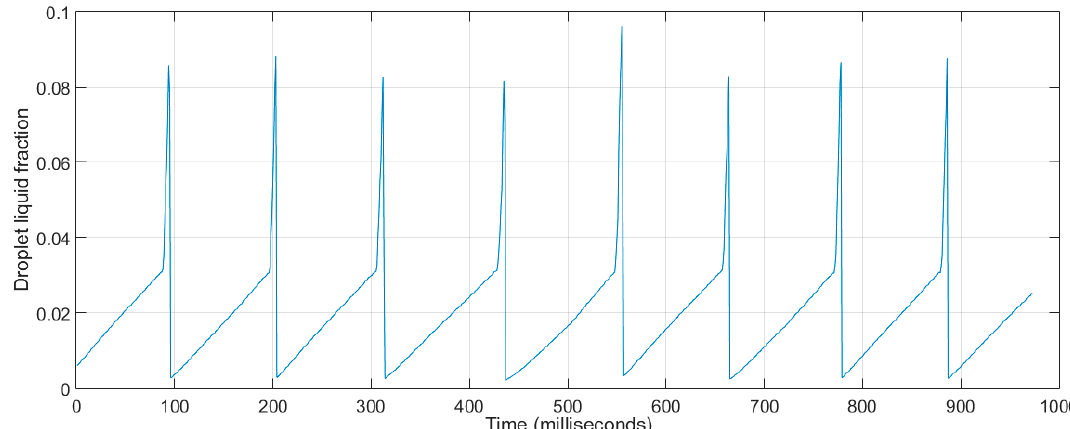
Figure 19. Liquid fraction distribution in droplet flow.